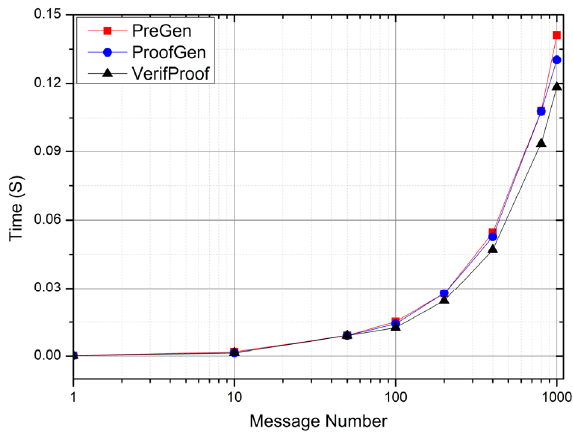
Figure 3. Overall performance of S-DIV scheme.